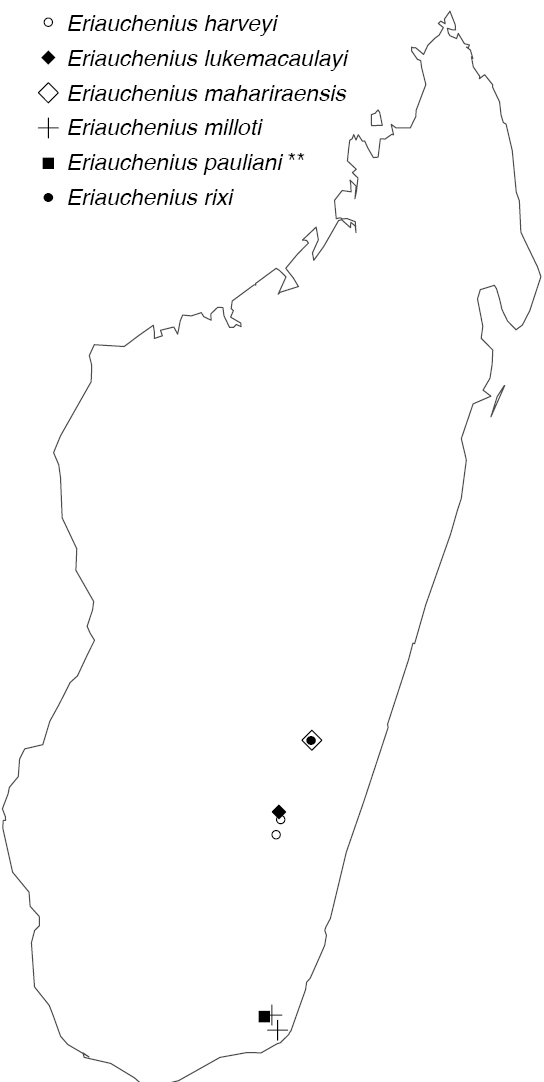
Distribution map for Eriauchenius species. ** The distribution for E.
pauliani is an approximation as the holotype does not have latitude/longitude data.